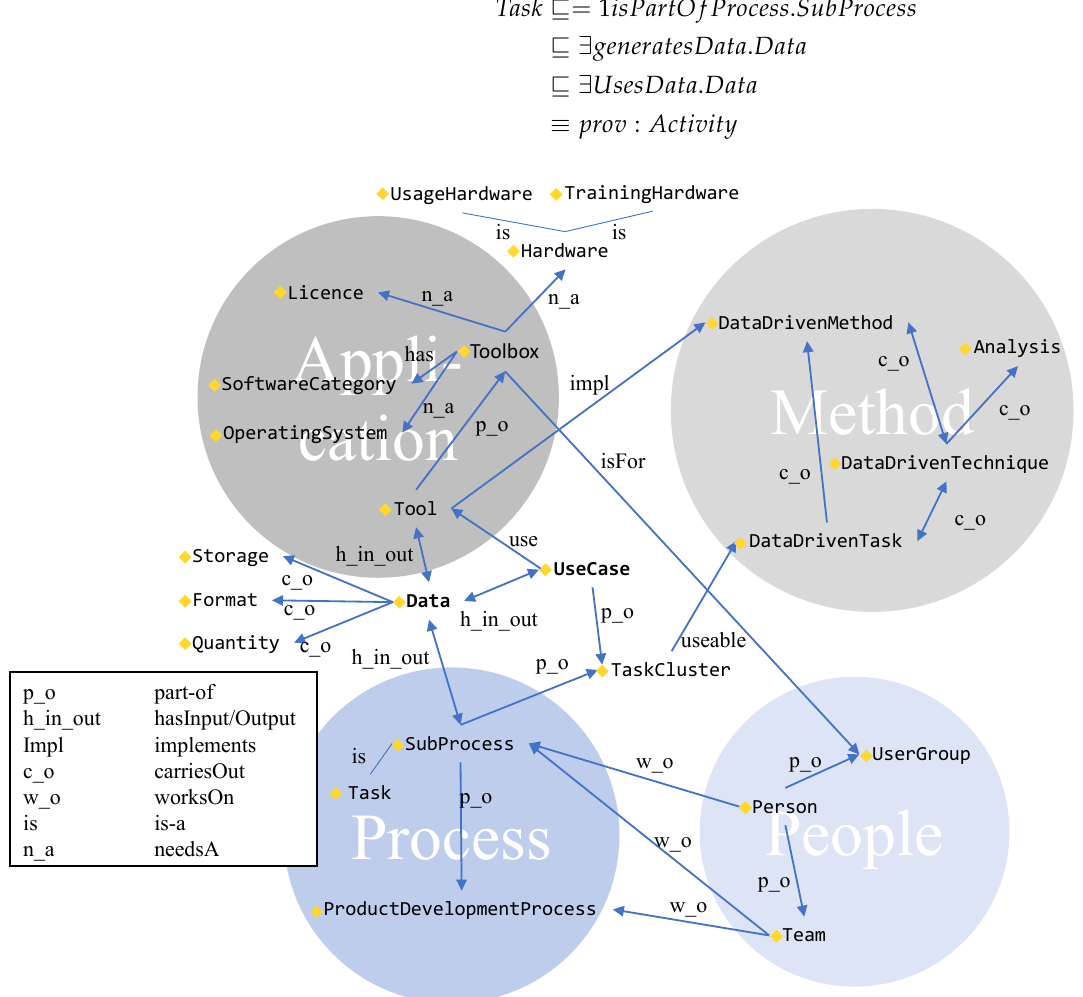
Figure 5. Core concepts (yellow diamond) and relationships (blue arrows) of